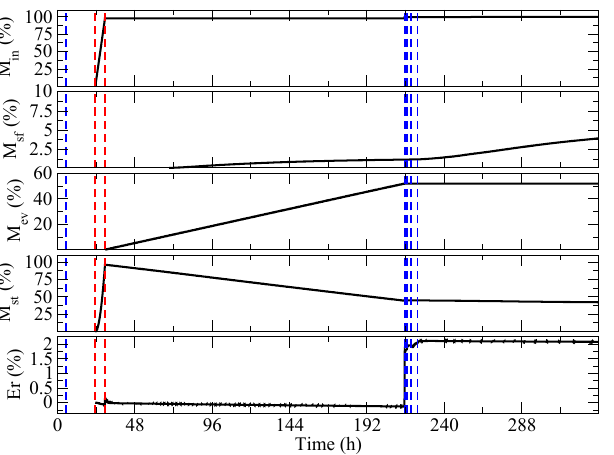
Figure 6. Simulated mass balance results for α l = 0 . 001m (simu- lation i of Table 3). From top to bottom: 2 H mass that enters the system, M in (normalized with respect to the total mass added to the system during the simulation); that exits through the seepage face, M sf ; that exits through evaporation, M ev ; and that remains in storage, M st . The bottom graph shows the cumulative mass balance error E r = (M in − M sf − M ev − M st ) . The vertical dashed lines in- dicate the timing of the three pulses of rain (red when the water is 2 H -enriched and blue when it is not).